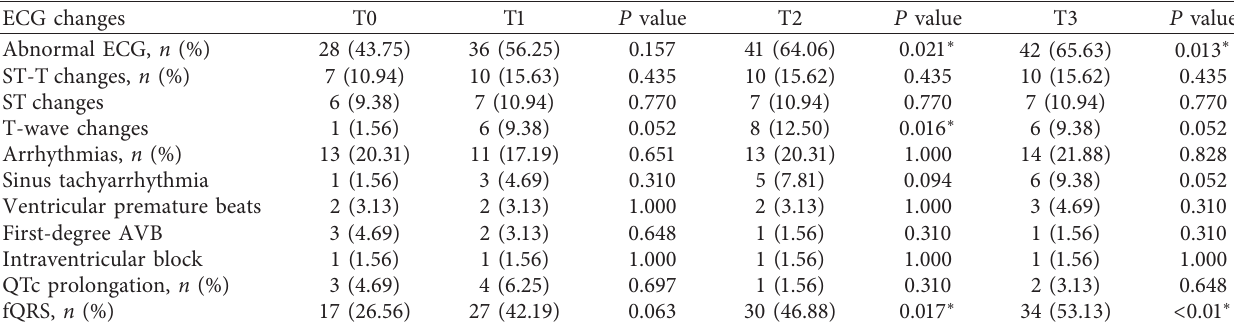
Table 3: ECG changes before and at each follow-up point during chemotherapy in BC patients. ECG changes